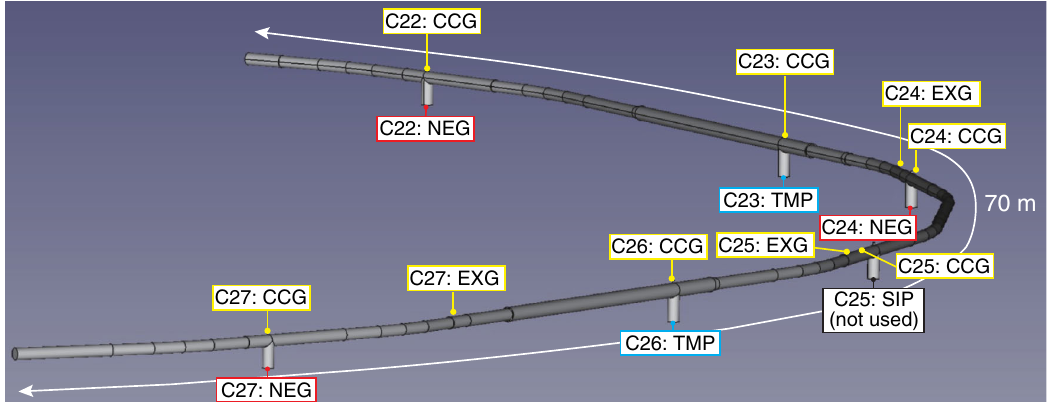
FIG. 24. Model of the M olflow+ calculation for the third arc section. The positions of the gauges and the pumps are also depicted.